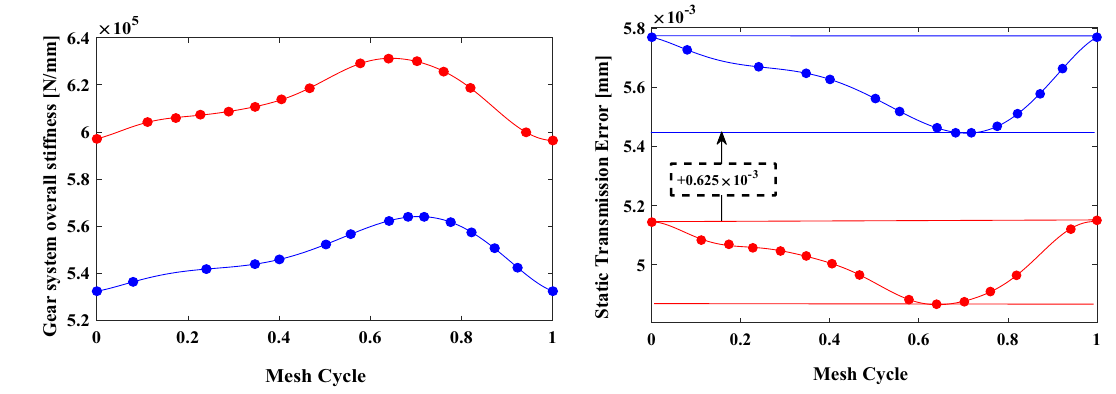
Fig. 3 GSOS and Static Transmission Error, blue line—case-1, red line—case-2, dots present Fourier spots, Ref. [14]